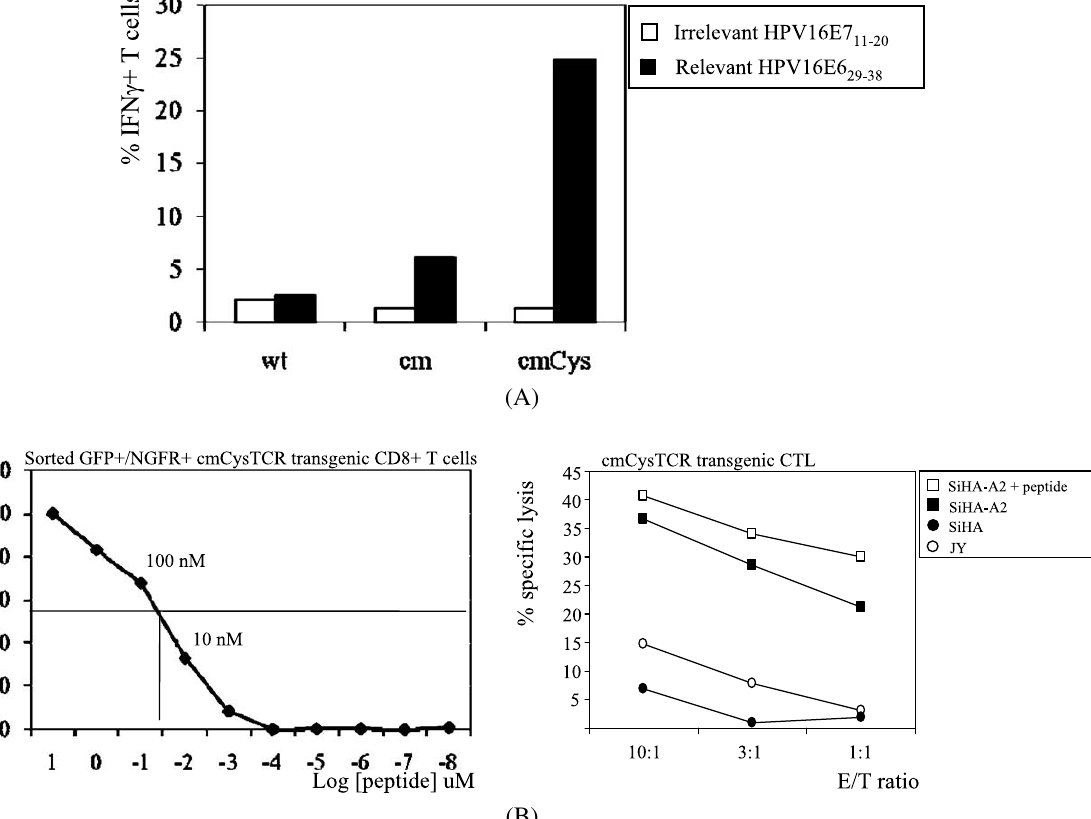
Fig. 4. Analysis of functional activity of CD8 + TCR transgenic T cells against peptide loaded target cells as well as tumor cells. (A) Bulk populations ( ∼ 95% GFP + /NGFR + ) wt, cm and cmCys TCR transgenic CD8 + T cells in an intracellular interferon- γ staining against JY cells loaded with irrelevant or relevant peptide. (B) Functional avidity as determined in an intracellular interferon- γ assay. The HLA-A2.1 + cell line JY loaded with decreasing amounts HPV16E6 peptide were used as target cell. The maximal interferon- γ production is set at 100%. The results indicate that 7E7-TCR transgenic CD8 + T cells recognize the E6 29–38 peptide with a half maximal interferon- γ production of ∼ 50 nM. Lytic activity of bulk cmCysTCR transgenic CD8 + T cells directed against the HLA-A2.1 negative cervical cancer cell line SiHA (closed circles), SiHA transfected with HLA-A2.1 (SiHA-A2, closed squares) and SiHA-A2 loaded with HPV16E6 peptide (open squares). Percentage specific lysis is shown for the indicated effector to target (E / T)